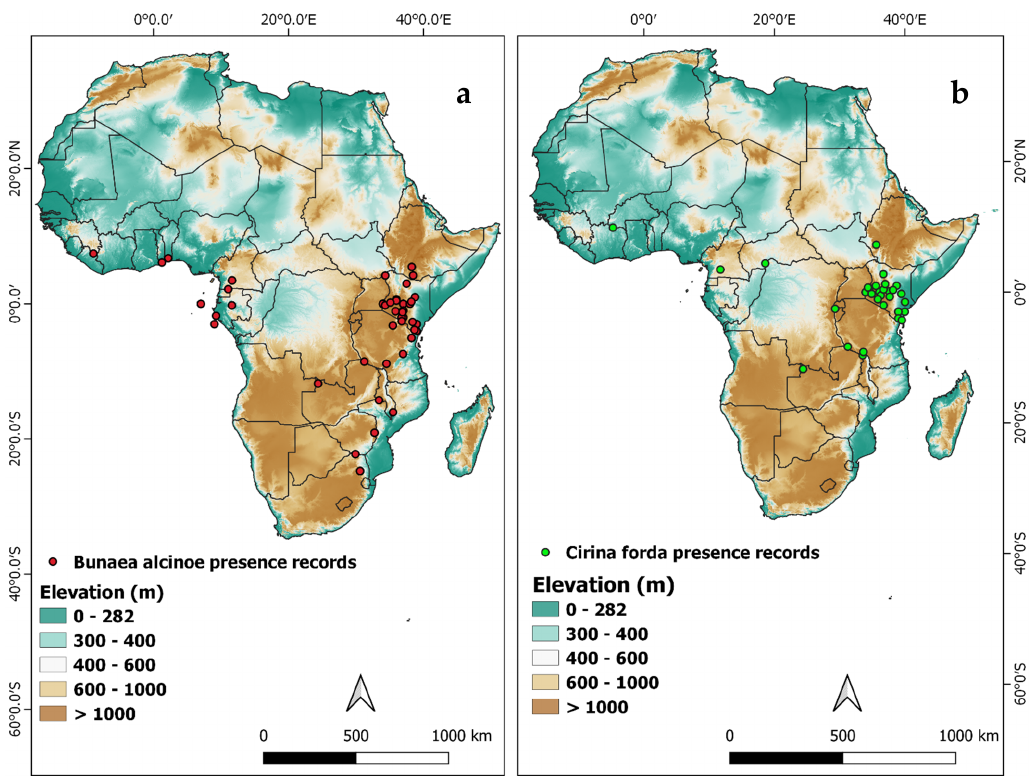
Figure 1. Geographical distribution records of ( a ) Bunaea alcinoe and ( b ) Cirina forda in Africa.